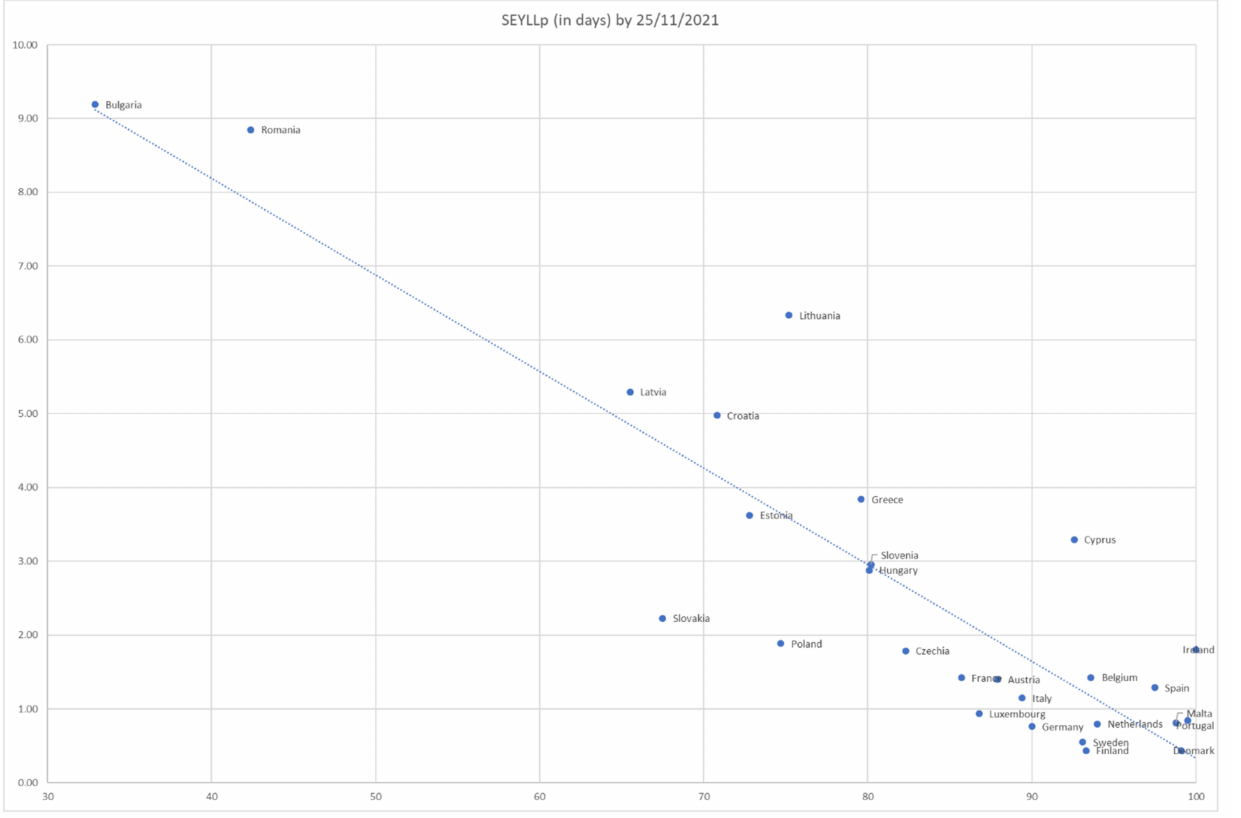
Figure 3. SEYLL p (in days) for the population over 60 in the 27 EU countries from 25 May 2021 to 25 November 2021 vs. their percentage vaccination